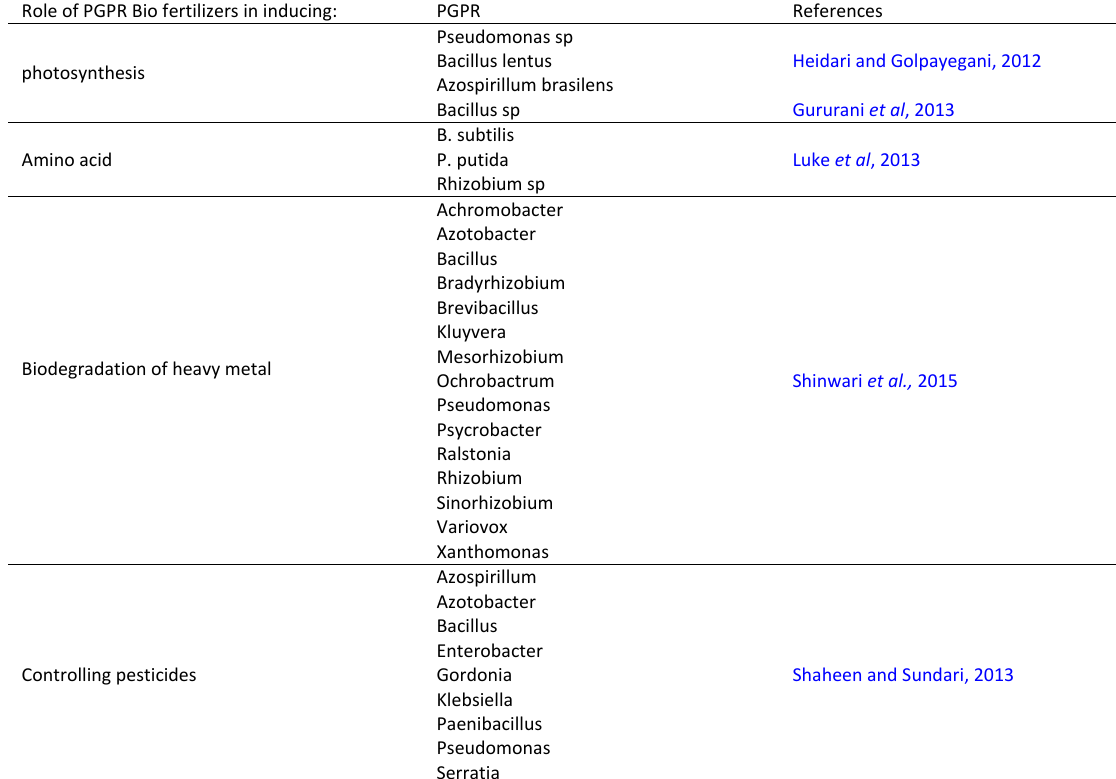
Table 2: PGPR bacterial strains utilized in bio-fertilizers and its role in plant growth Role of PGPR Bio fertilizers in inducing: